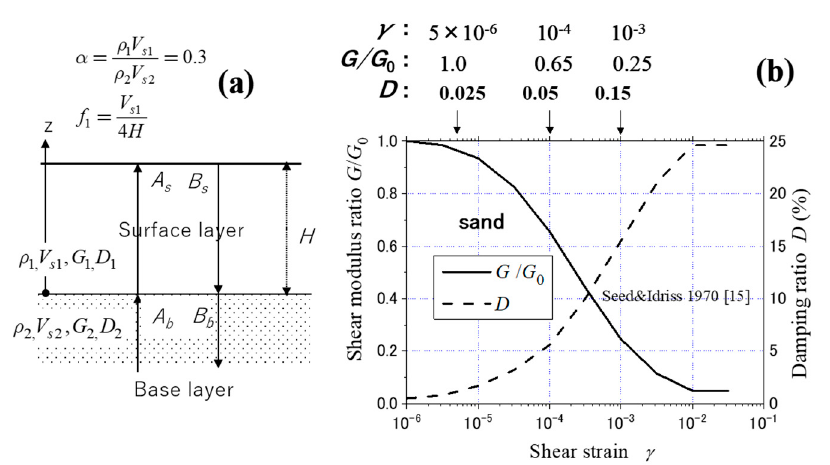
Figure 14. Two-layers model calculating soil nonlinearity effect on site amplification ( a ), and Strain dependent variations of normalized shear modulus G / G 0 and damping ratio D at three strain levels ( b ).